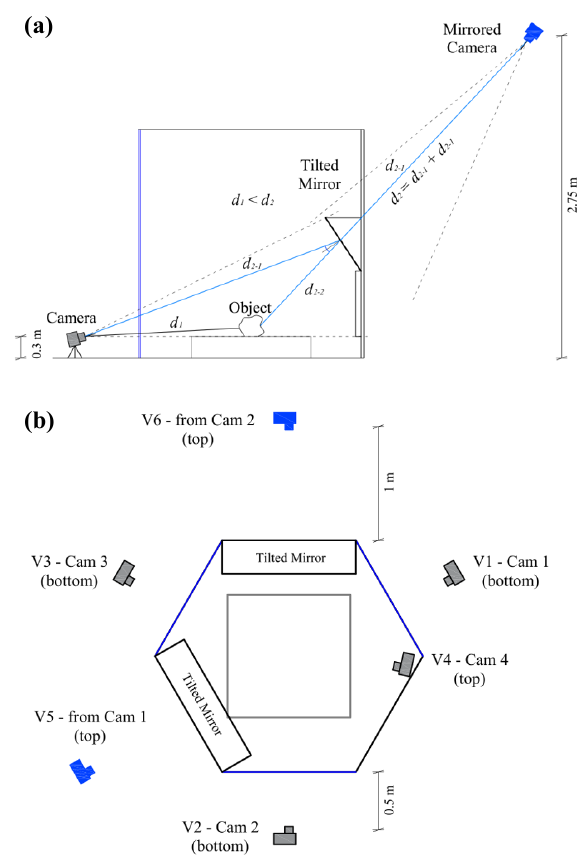
Figure 2. Sketches showing the concept of the mirrored views: (a) camera and mirror with object distances (b) physical viewpoints V1 to V4 for Cam 1 to Cam 4 and virtual viewpoints V5 and V6 for the mirrored views